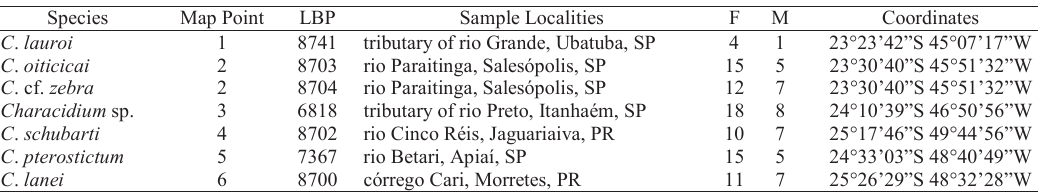
Table 1. Specimens of Characidium analyzed in this study. LBP = catalog number of vouchers; F = female; M = male; SP = São Paulo State; MG = Minas Gerais State; PR = Paraná State.